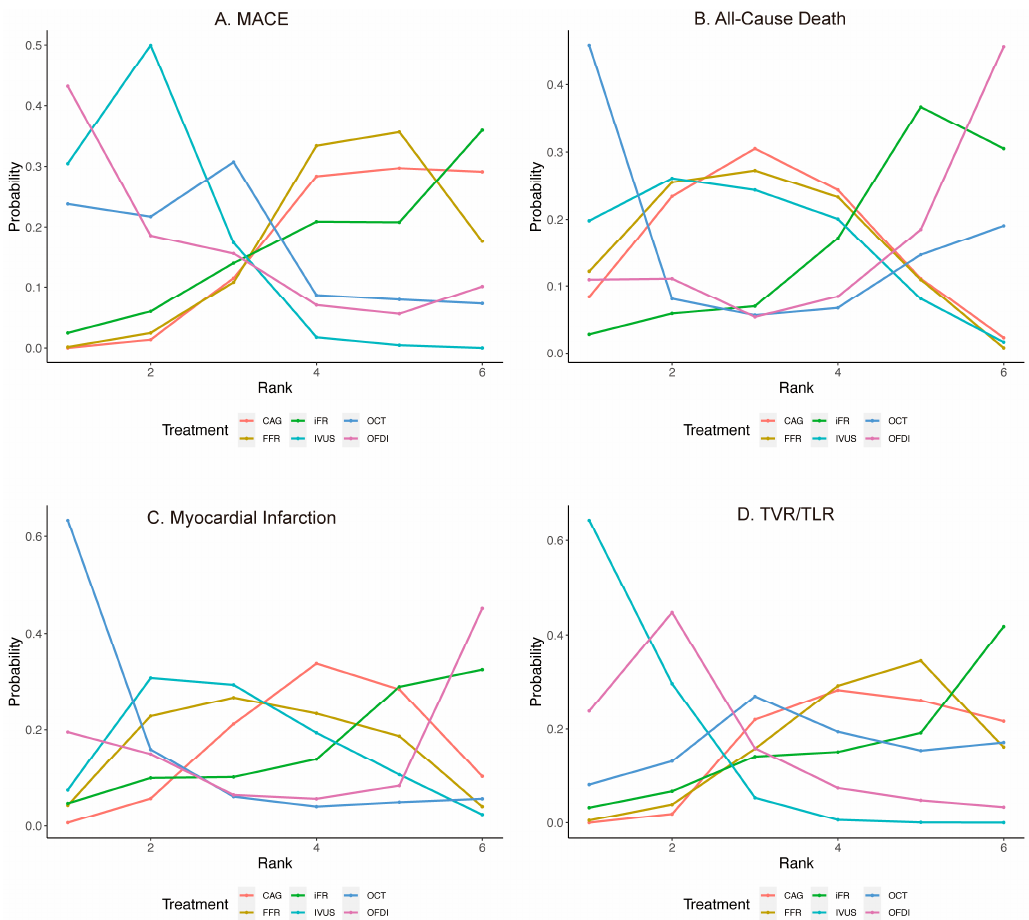
Figure 2. Comparisons of clinical outcomes among guidance modalities included in the network meta-analysis. CAG: coronary angiography; FFR: fractional flow reserve; iFR: instantaneous wave- free ratio; IVUS: intravascular ultrasound; MACE: major adverse cardiovascular events; OCT: opti- cal coherence tomography; OFDI: optical frequency domain imaging; TVR/TLR: target vessel/lesion revascularization. ( A ) MACE; ( B ) All-Cause Death; ( C ) Myocardial Infarction; ( D ) TVR/TLR